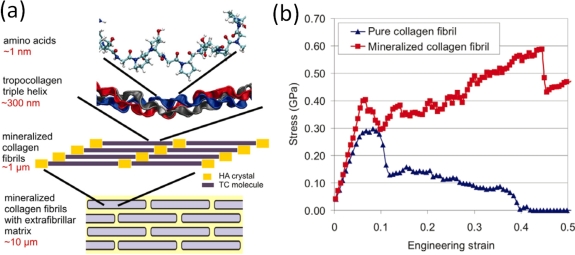
(a) Hierarchical features of collagen which determines the mechanical properties of cells, tissues, bones and many other biological systems, from atomistic to microscale. Three polypeptide strands arrange to form a triple helical tropocollagen molecule. Tropocollagen (TP) molecules assemble into collagen fibrils which mineralize by formation of hydroxipatite (HA) crystals in the gap regions which exist due to a staggered array of molecules. (b) Stress-strain response of a mineralized collagen fibril exhibiting larger strength than a non-mineralized, pure collagen fibril. Both figures adapted from [227] with permission.